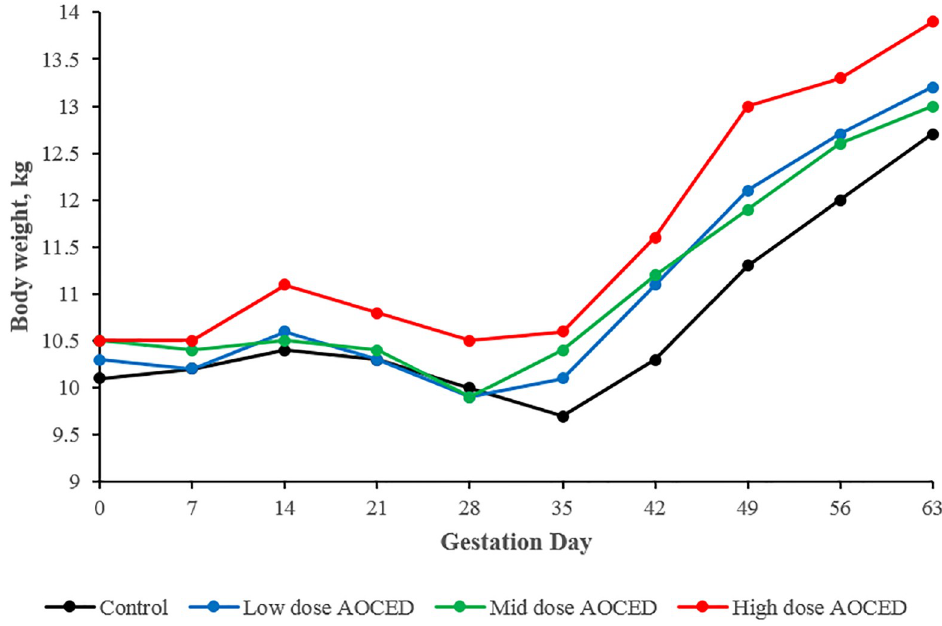
Fig 1. Body weights of females during gestation. Values are shown as group means (n =